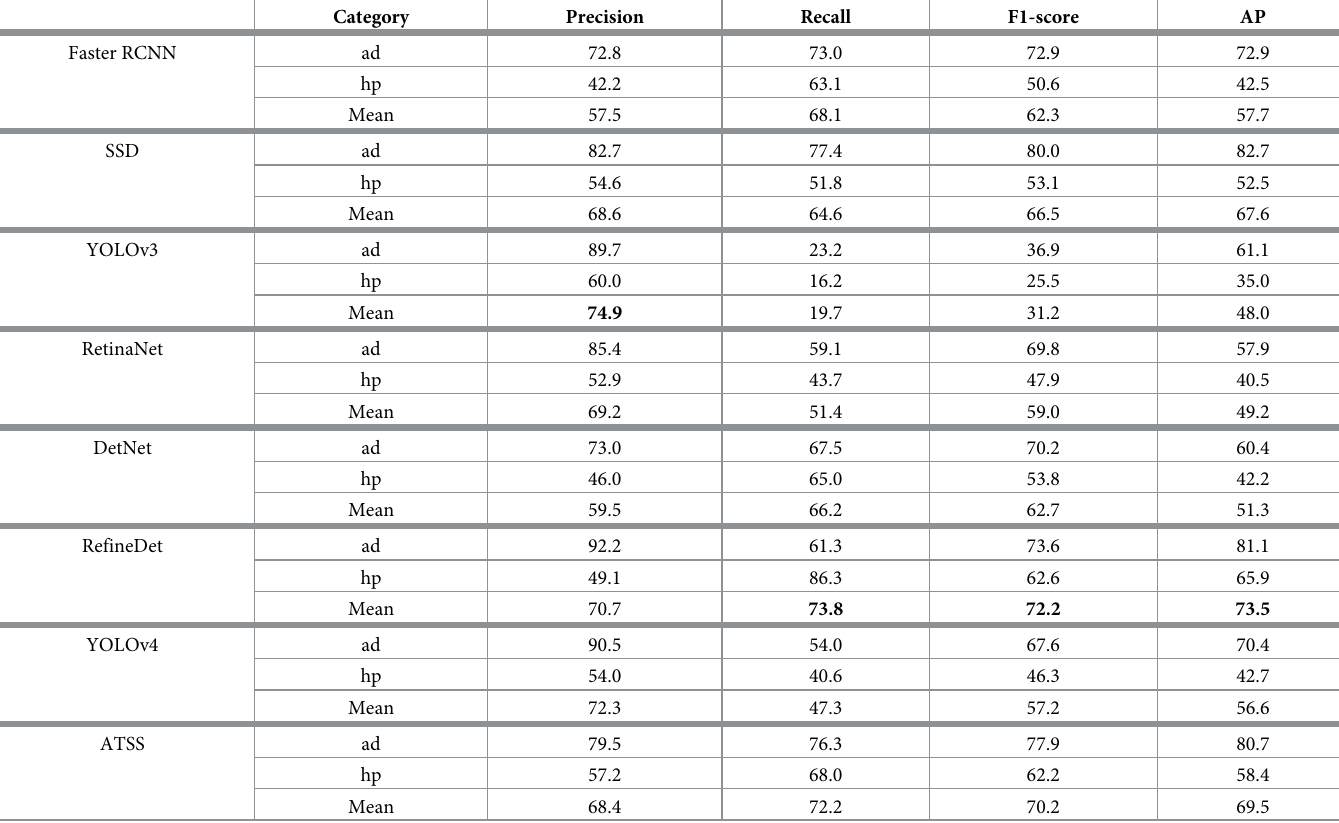
Table 3. Results for frame-based two-class polyp detection. Category